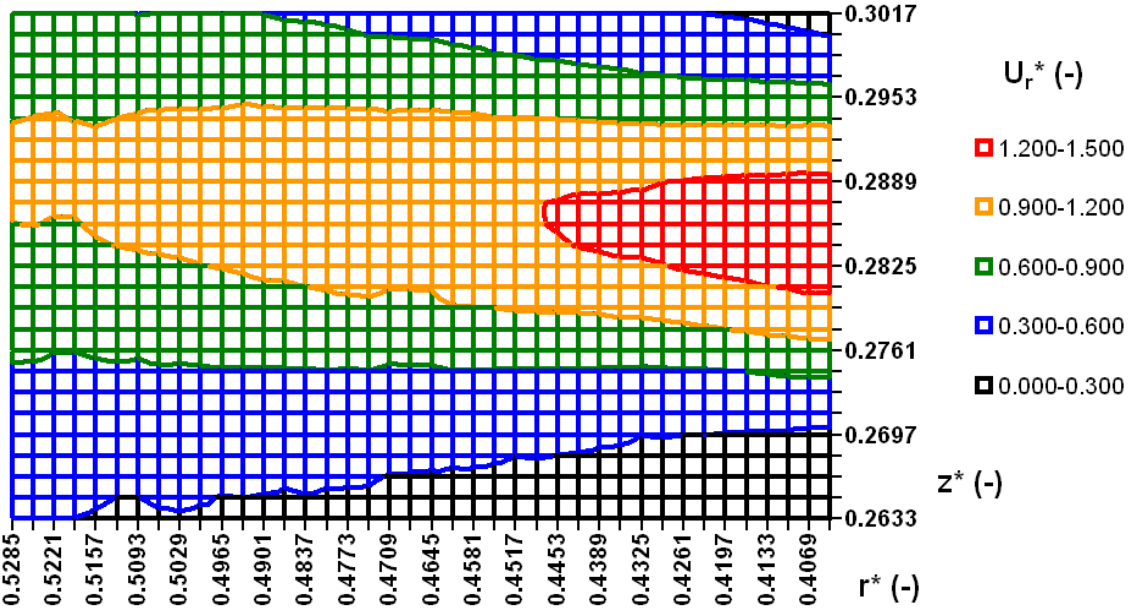
Fig. 2. Dimensionless radial mean velocity distribution U r* = )/( NDU